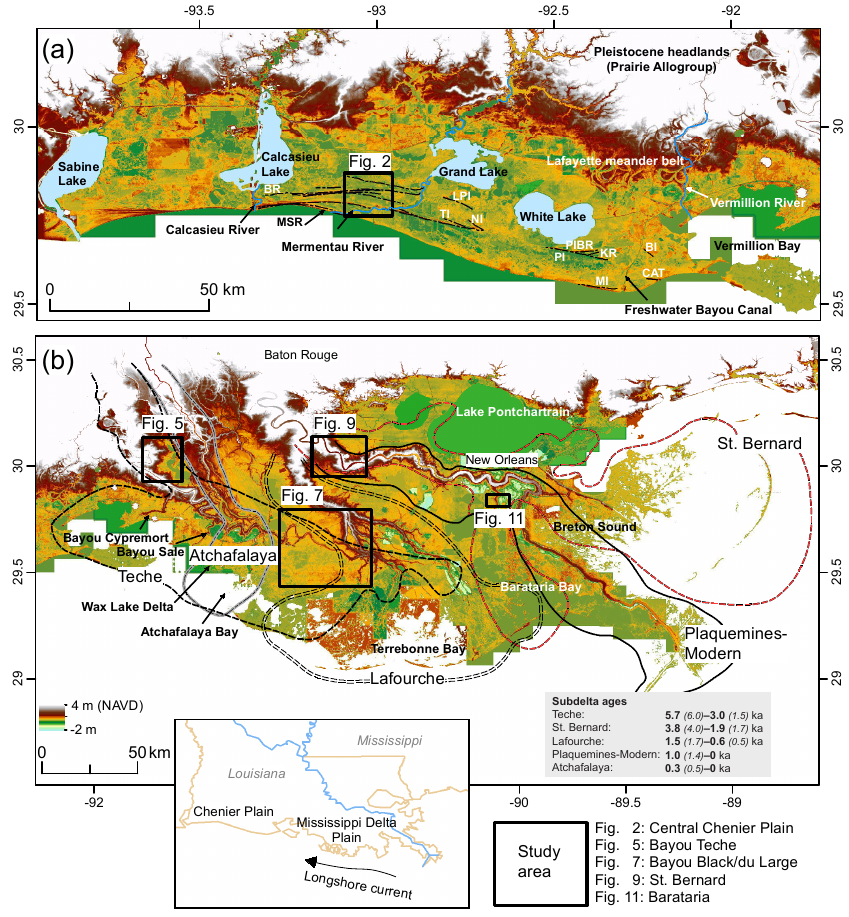
Figure 1. Digital elevation maps (NED 1/1arcsec; Gesch, 2007; LSU, 2011) of the study areas, including (a) the Chenier Plain with the main cheniers indicated by the black lines and (b) the Mississippi Delta plain with the position of its subdeltas. The outline of the subdeltas is essentially the same as in Frazier (1967), but in line with Fisk (1944) the Teche subdelta extends farther east. BR: Back Ridge; MSR: Mesquitte Ridge; TI: Tiger Island; LPI: Little Pecan Island; NI: North Island; PI(BR): Pecan Island (Back Ridge); MI: Mulberry Island; KR: Kochs Ridge; BI: Belle Island; CAT: Chenier au Tigre. In the box with subdelta ages the bold numbers indicate the period of activity, while the smaller numbers in italics reflect the possible period of activity (see also Fig.